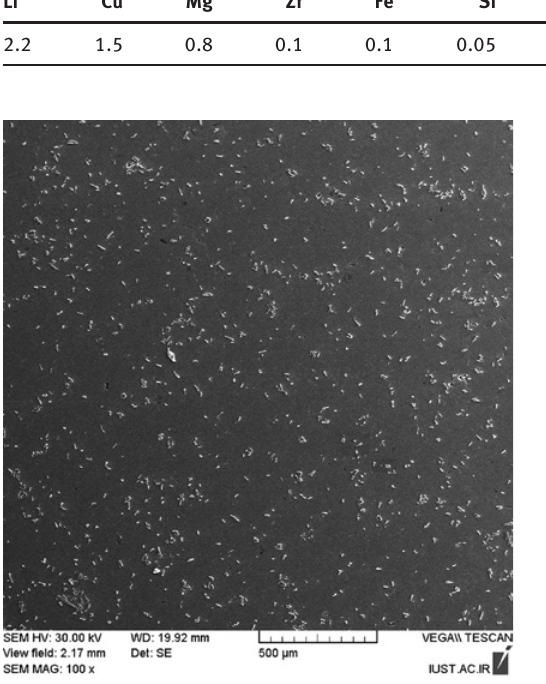
composite in the p